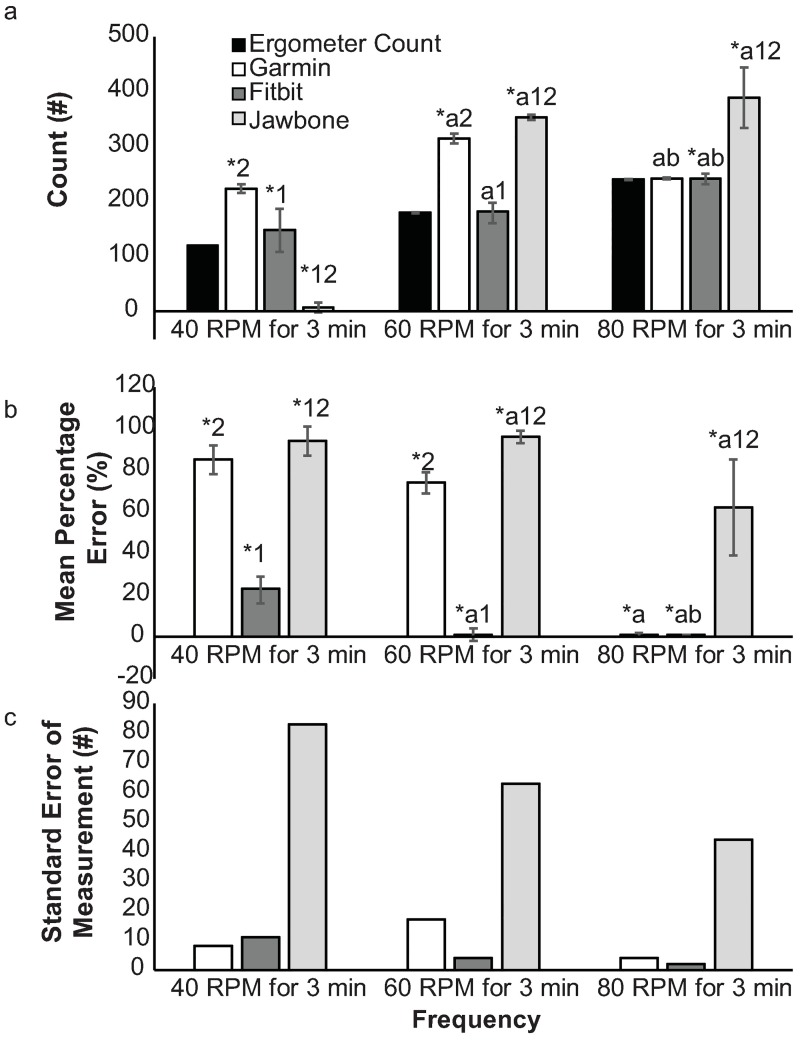
Ergometer task statistics.Means and 95%CI for (a) counts, (b) mean percentage error, and (c) standard error of measurement. Significant difference (p≤.05) *from true values, afrom 40 rpm, bfrom 60 rpm, 1from Garmin, 2from Fitbit.